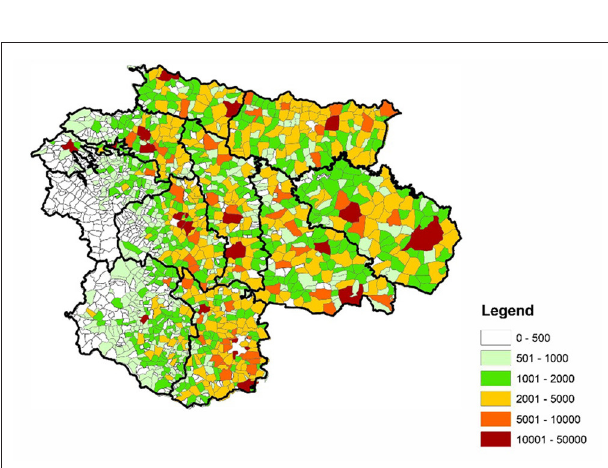
FIGURE 12 | Geomorphological patterns and constraints (GSDA data interpreted by authors). FIGURE 13 | Village population size according to major Census